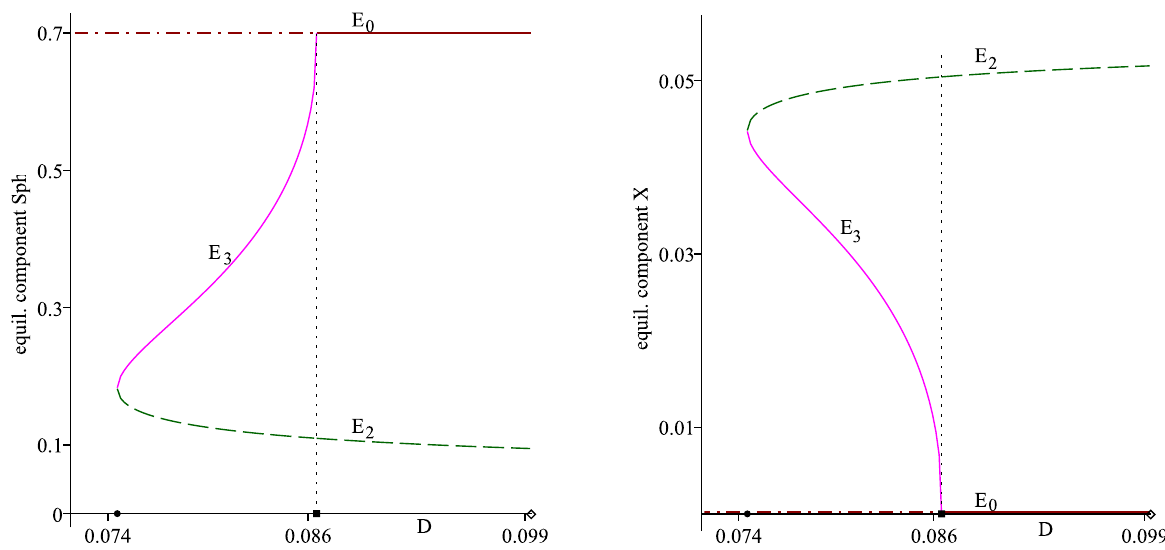
( 2 ) ( 3 ) (dash line) and S (solid line), parameterized on D . The horizontal dash- ph ph . ( Right ): the equilibrium components X ( 2 ) (dash line) and X ( 3 ) (solid line), parameterized ph ( 2 ) cr , the diamond denotes D cr . The vertical dot line passes through D